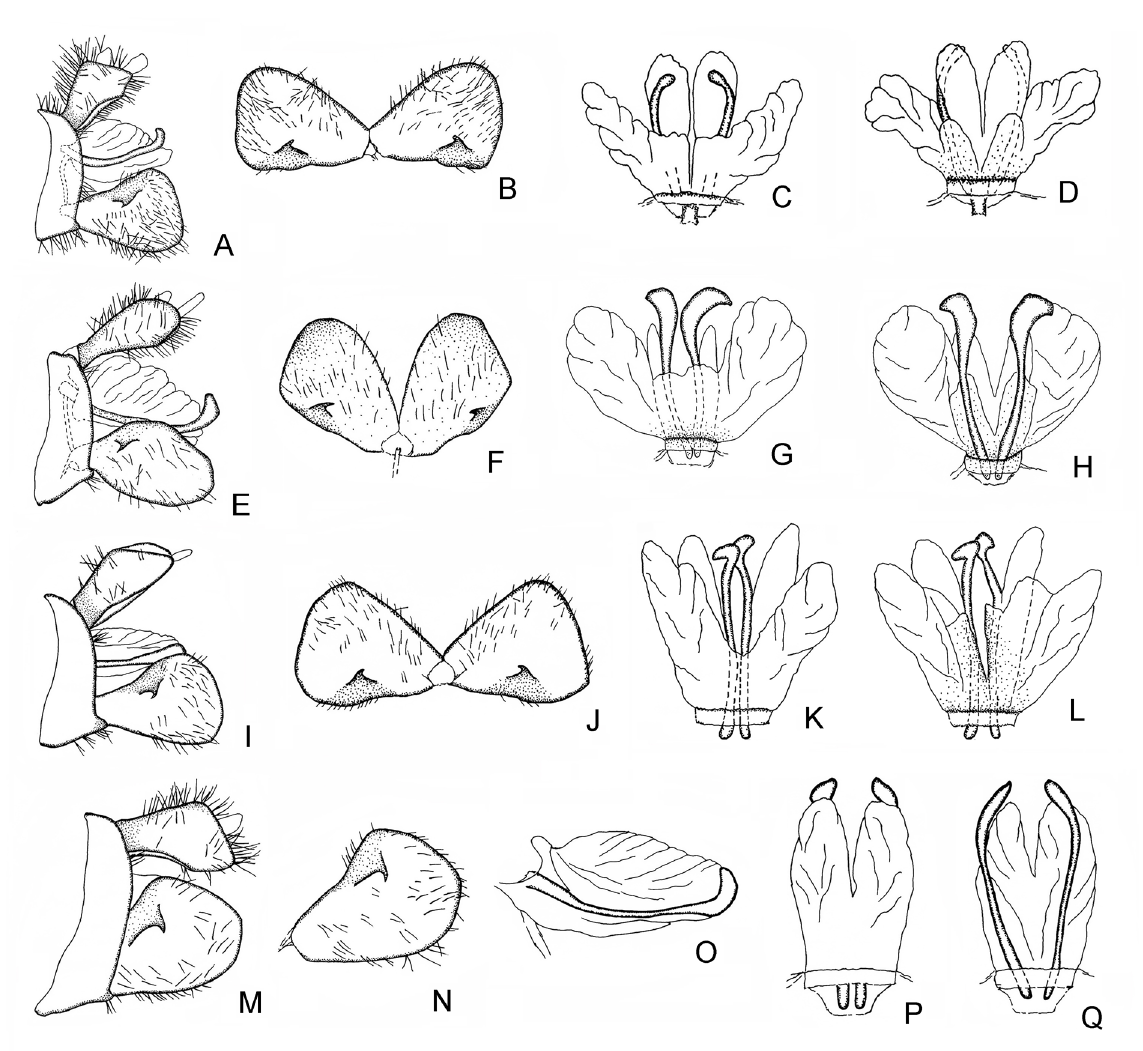
Fig. 14. Male genitalia. A – D . Limois chagyabensis Chou & Lu, 1981, NWAFU HO088523. A . Left lateral view. B . Gonostylus, ventral view. C . Aedeagus, dorsal view. D . Aedeagus, ventral view. – E – H . Limois guangxiensis Chou & Wang, 1985, NWAFU HO088509. E . Left lateral view. F . Gonostylus, ventral view. G . Aedeagus, dorsal view. H . Aedeagus, ventral view. – I – L . Limois hunanensis Chou & Wang, 1985, NWAFU HO088511. I . Left lateral view. J . Gonostylus, ventral view. K . Aedeagus, dorsal view. L . Aedeagus, ventral view. – M – Q . Limois kikuchii Kato, 1932, Manchuria, K. Kikuchi leg., RBINS. M . Left lateral view. N . Gonostylus, left lateral view. O . Aedeagus, left lateral view. P . Aedeagus, dorsal view. Q . Aedeagus, ventral